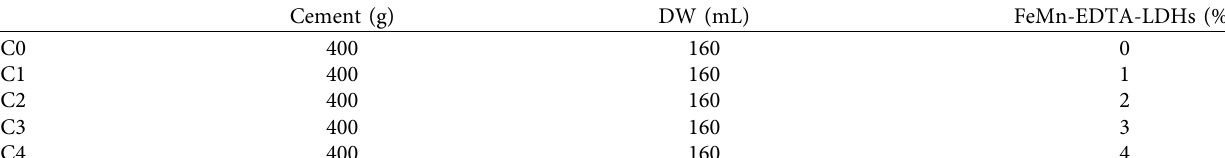
Table 1: Proportioning of cement